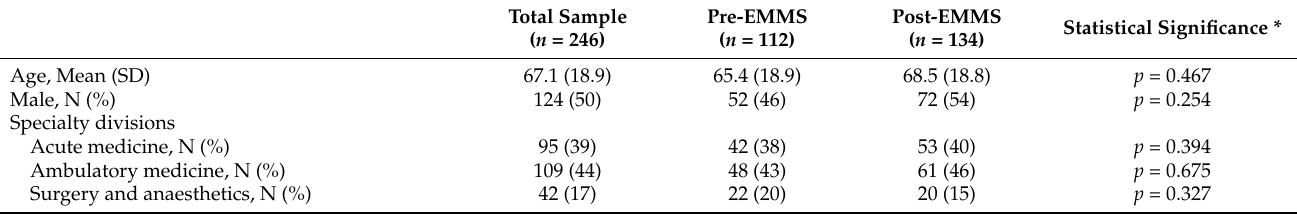
Table 1. Demographic of patients in pre-EMMS and post-EMMS in hospital-wide